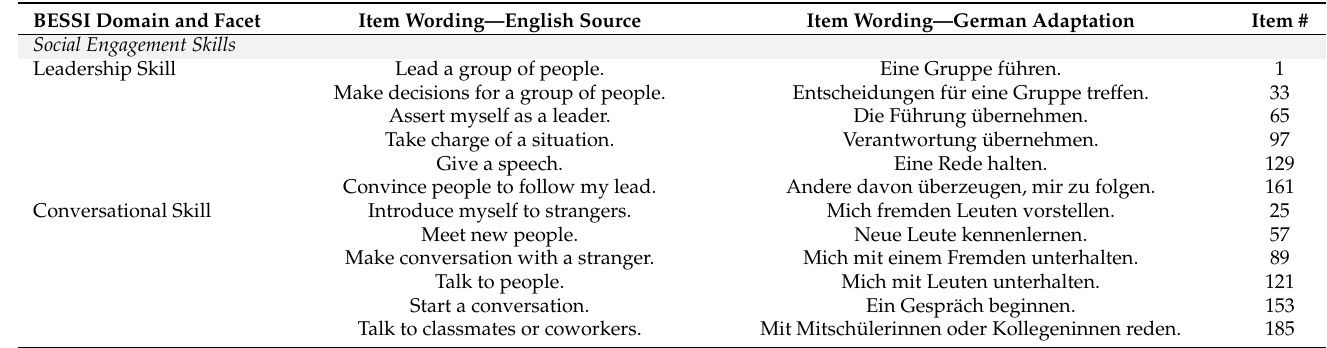
Table A6. English-language BESSI source versions (from Soto et al. 2022) and final German transla- tions (BESSI-G v0.2) of the 192